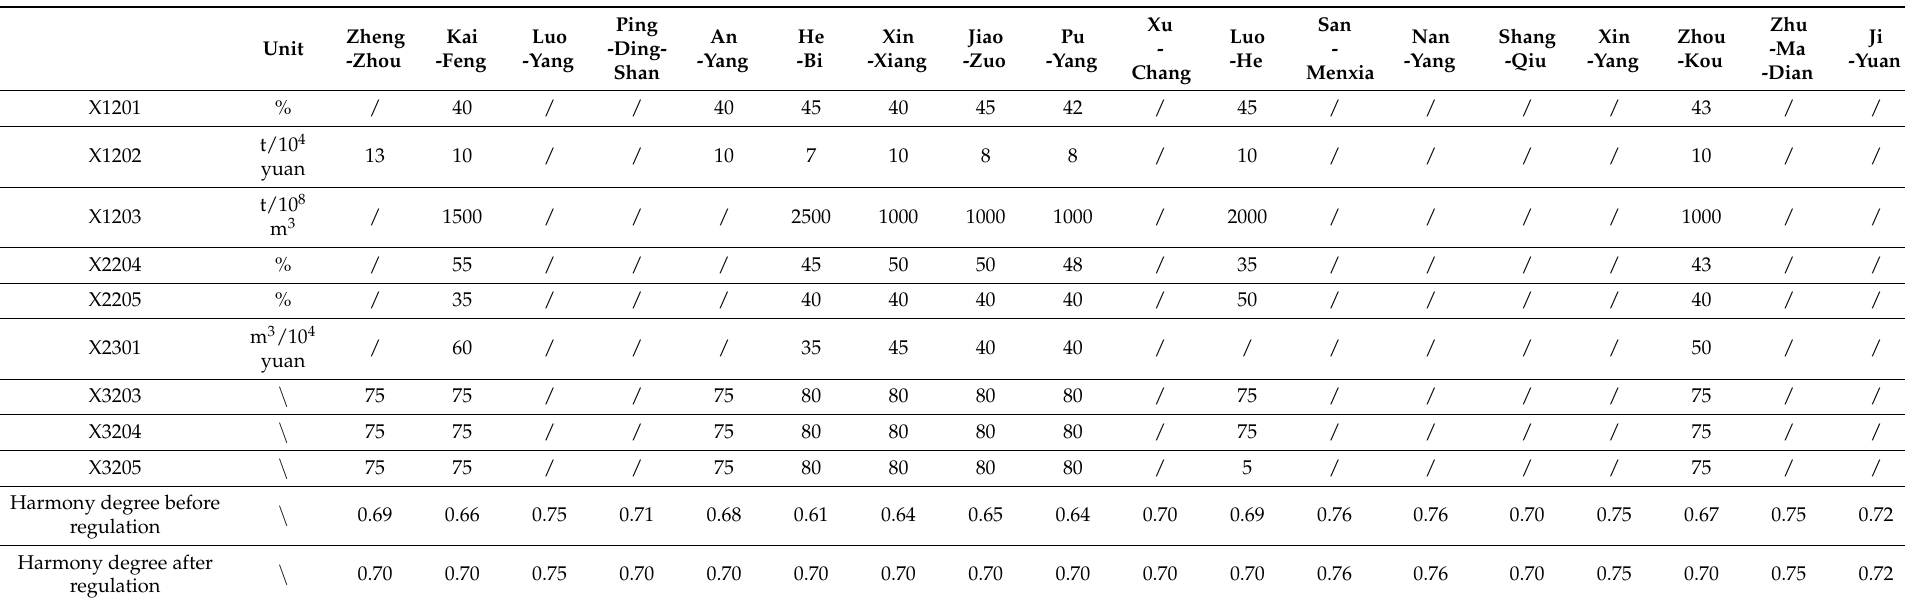
Table 2. Results of harmony regulation in Henan Province in